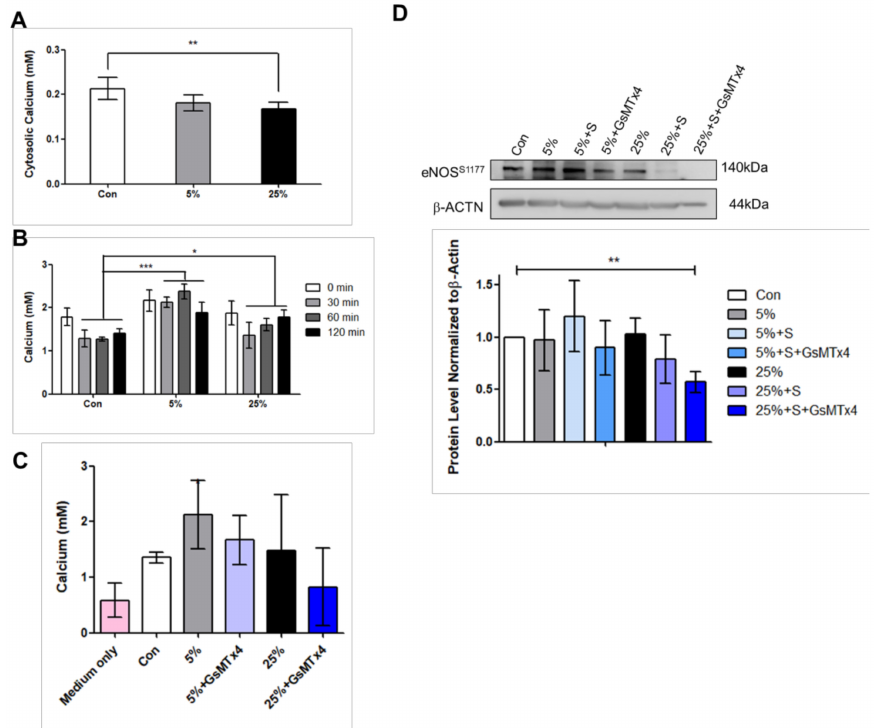
Figure 4. Aggressive mechanical stimulation reduces calcium ion and P-eNOS levels. ( A ) Cardiomyocytes cell pellets were collected and lysed in lysis buffer after 24 h stretching, cytosolic calcium ion determined by colorimetric detection kit. ( B ) Calcium ions released into the medium was measured immediately after stretching at 0 min, 30, 60, and 120 min. The medium which was the supernatant were collected simultaneously, absorbance measured at 575 nm. ( C ) Calcium ion released into the medium was measured after 24 h stretching with Piezo1 inhibited (Piezo1 inhibitor GsMTx4) at 5%, and 25%. ( D ) After 21 h of stretching, the cardiac drug simvastatin, or GsMTx4 was added to the cells, and continued cultured for 3 h before collecting cell lysates at 24 h. Data represent at least three independent experiments in SEM ± SD. *, p value < 0.05, **, p value < 0.01, ***, p value <